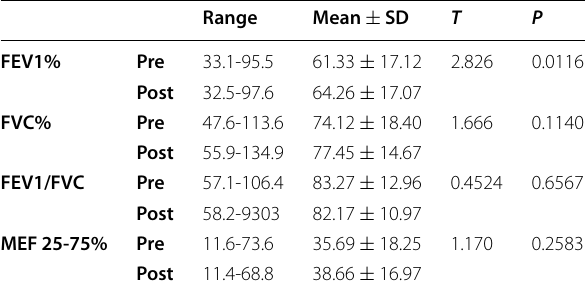
Table 6 Spirometric pulmonary function testing among the patients groups before and after nutritional